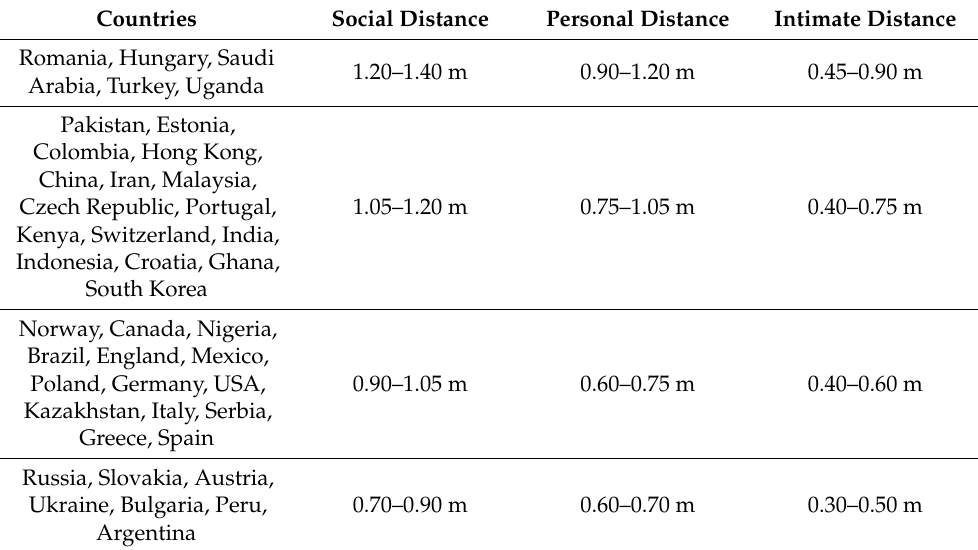
Table 1. Average preferred interpersonal distance (in meters) for different types of social relations: strangers, acquaintances, and partners/close relations across all nations. The figure estimations were conducted by Sorokowska et al. [33].